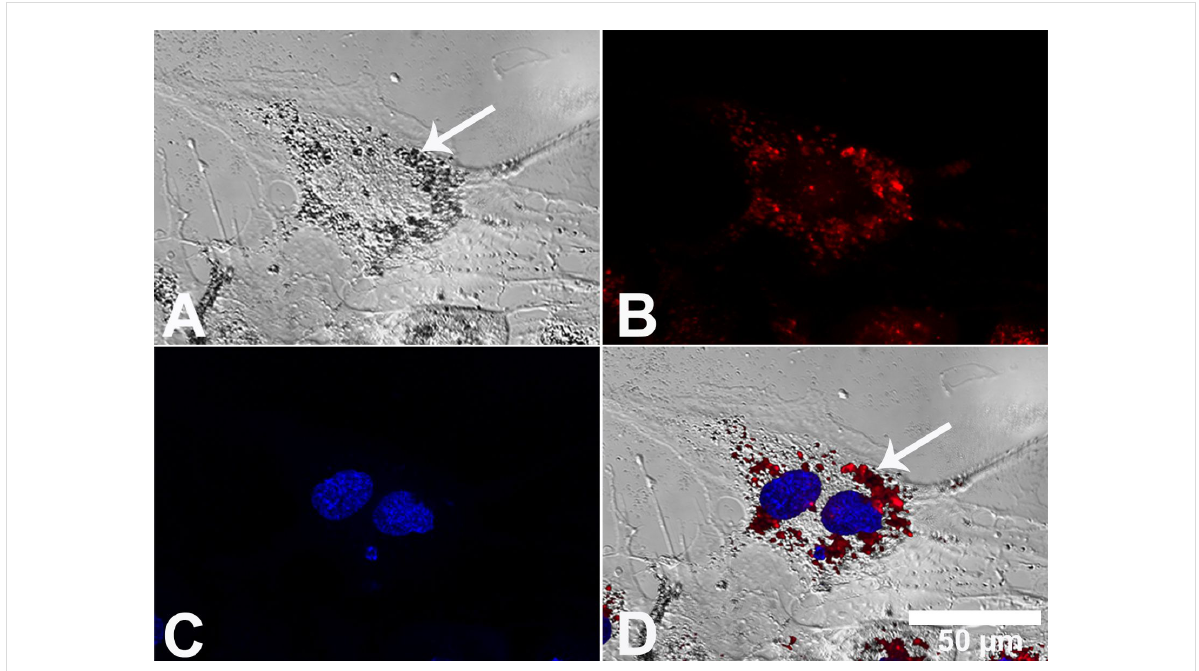
Figure 1: Localization of Ag-NP agglomerates in hMSCs. Representative light micrographs after digital contrast enhancement (DCE filter) (A), laser scanning micrographs (B,C) and combinations of both (D) are shown. The white arrow denotes the intracellular accumulation of silver particles inside the endo-lysosomes (A,D). The blue fluorescence of Hoechst 33342 and the red fluorescence of LysoTracker Red DND 99, which were used as probes of the cell nucleus (C) and endo-lysosomes (B), respectively, are